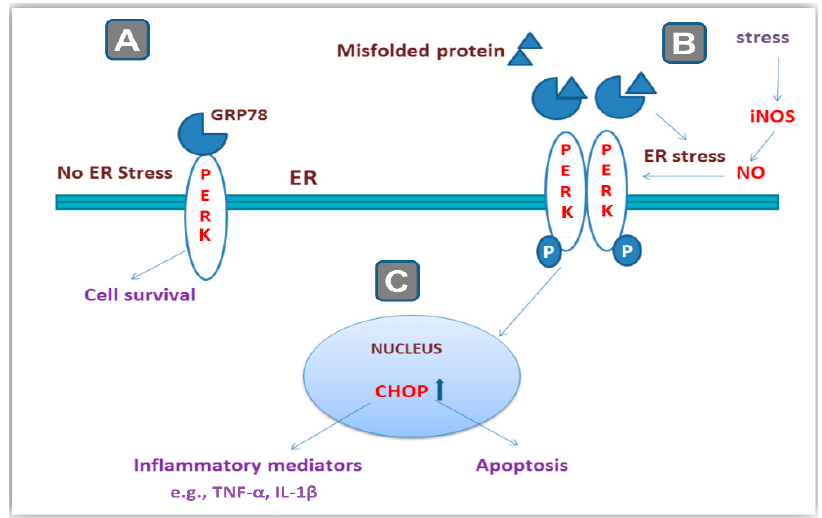
Figure 1. An overview of endoplasmic reticulum (ER) stress and its relationship to cellular stressors and PERK/GRP78/CHOP pathway. ( A ) Under normal conditions when the neurons are not subjected to stressors, the protein kinase RNA-like endoplasmic reticulum kinase (PERK) is kept in an inactive state by binding to glucose-regulated protein 78 (GRP78). ( B ) When cells encounter stressors including excessive nitric oxide (NO) synthesized by inducible nitric oxide synthase (iNOS), the ER stress takes place where misfolded proteins accumulate inside the ER of neurons. As a result, GRP78 is dissociated from PERK which then undergoes phosphorylation/dimerization, triggering its activation. ( C ) The later event upregulates the protein expression of the C/EBP-homologous protein (CHOP) signal culminating in several pro-apoptotic responses and neuronal cell loss alongside the increased synthesis of multiple pro-inflammatory cytokines, such as tumor necrosis factor-alpha (TNF- α ) and interleukin 1 beta (IL-1 β ).